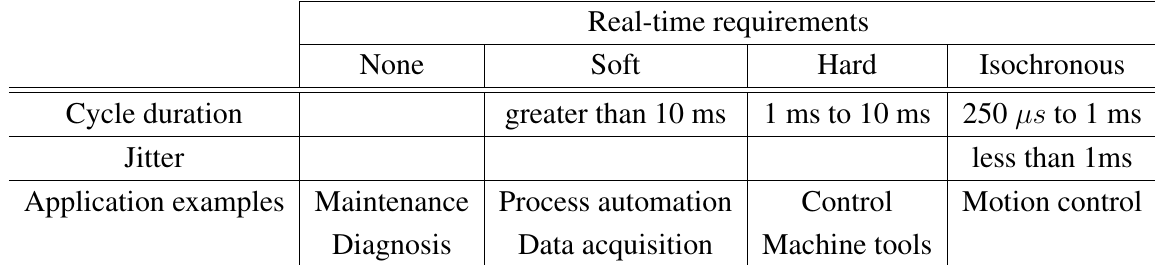
Table 2. Industrial automation applications classified according to their real-time require- ments